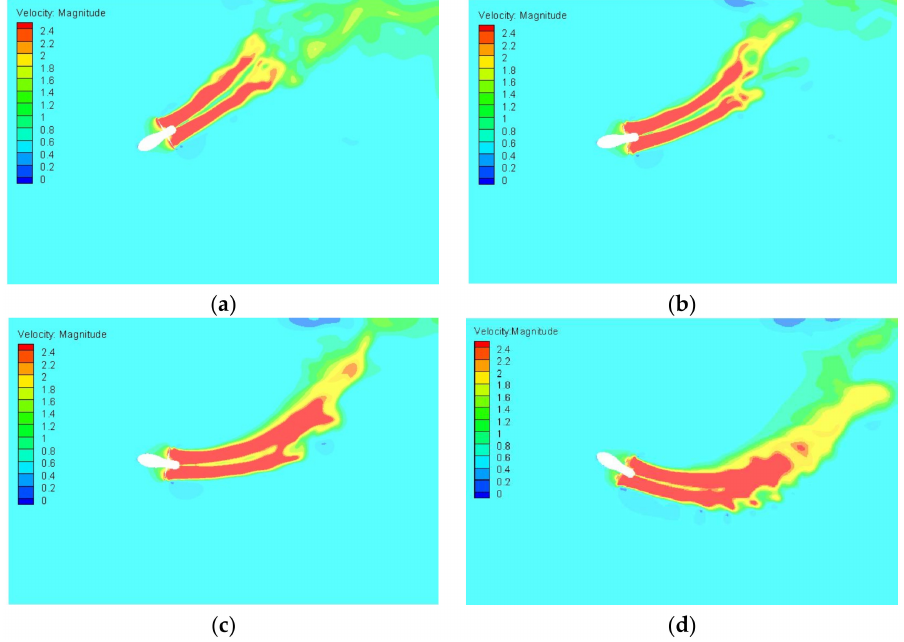
Figure 17. Process of changing the pod unit from starboard to port under maneuvering conditions ( J = 0.2): ( a ) Oblique flow − 30 ◦ ; ( b ) Oblique flow − 10 ◦ ; ( c ) Oblique flow 10 ◦ ; ( d ) Oblique flow 30 ◦